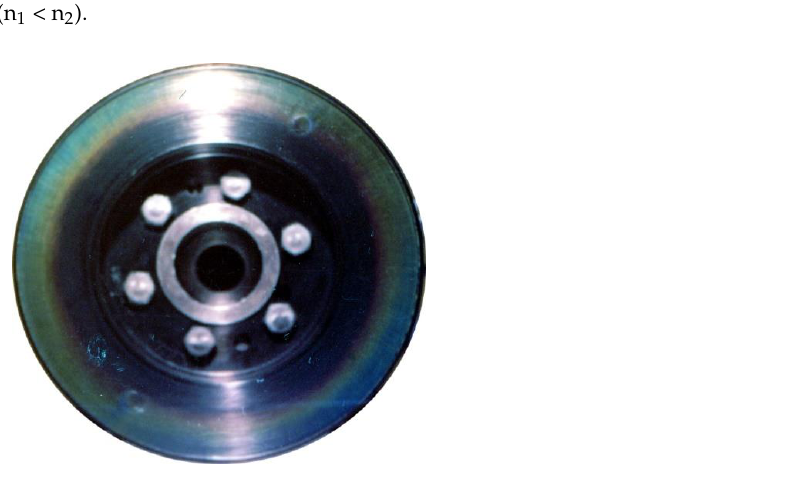
Figure 11. Overheated viscous torsional vibration damper [7].